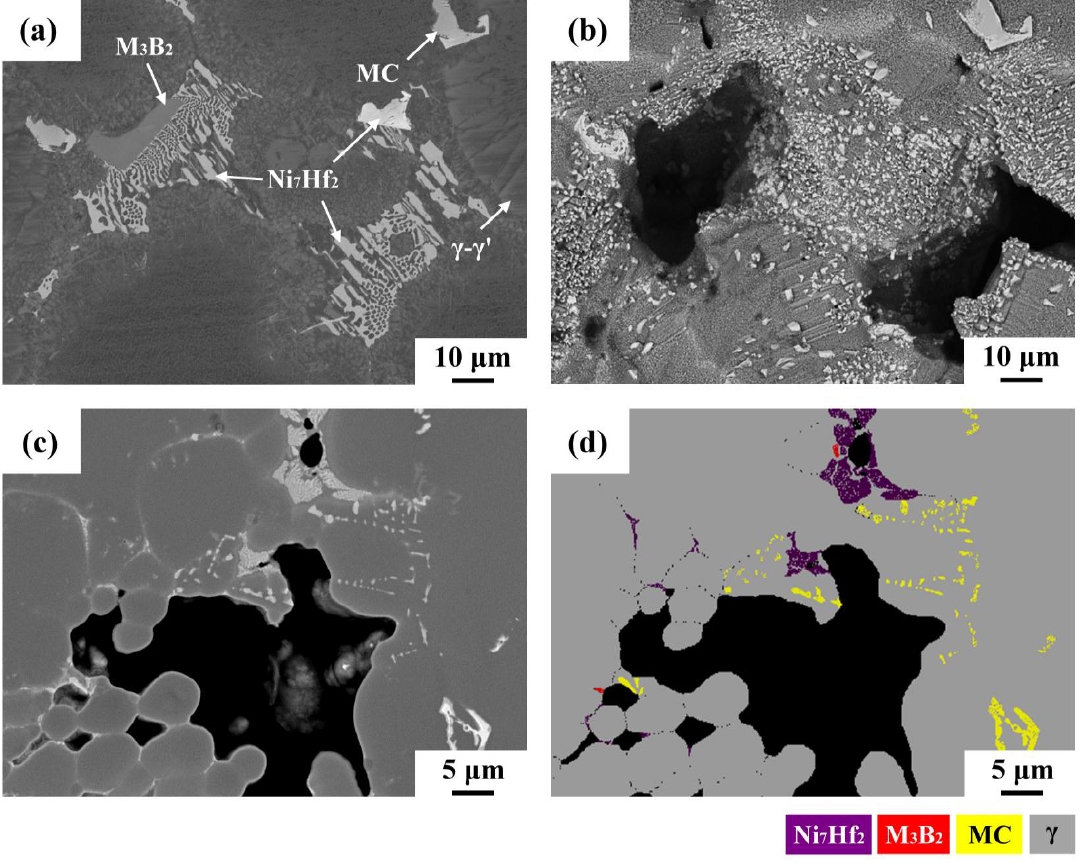
Figure 8. ( a ) BSE image of the cast microstructure; ( b ) the microstructural change of the ( a ) sample after solution-treatment at 1180 °C for 4 h; ( c ) BSE image of the liquated sample after metallographic preparation; and ( d ) EBSD map of the ( c ) sample.